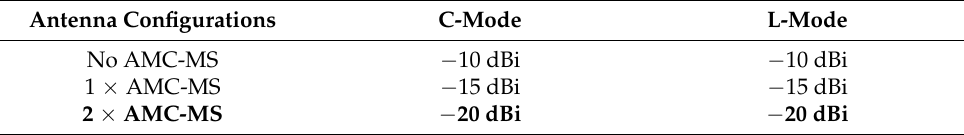
Table 3. Back lobe radiation characteristics without/with the presence of AMC-MS structures